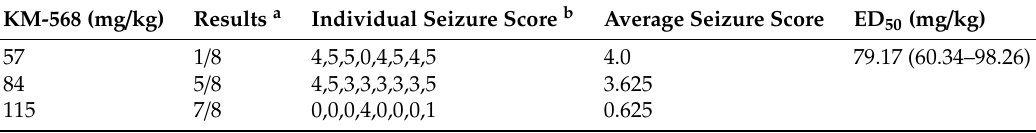
Table 6. Results of cornel kindling in mice after 0.5 h of i.p. administration of KM-568.